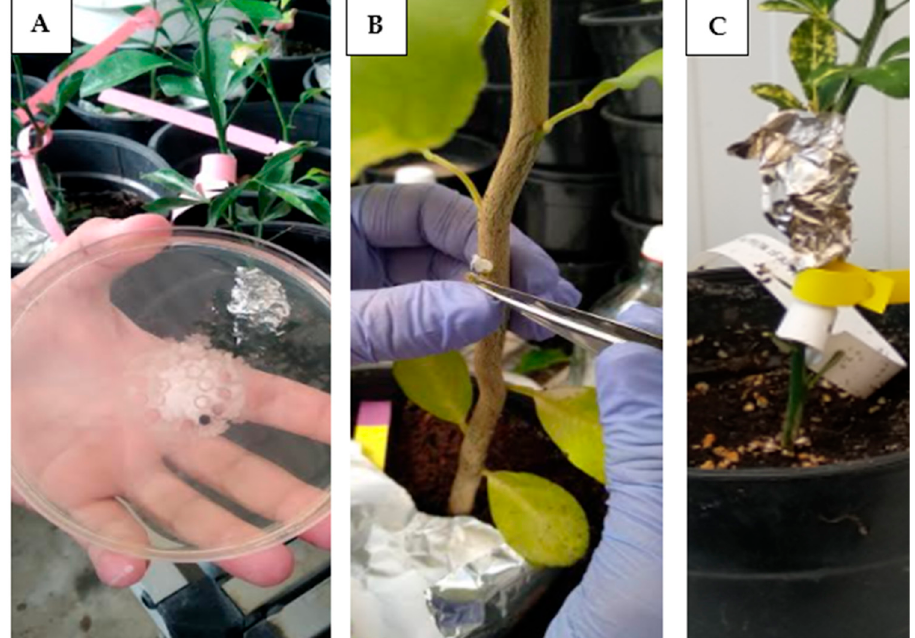
Figure 1. Phytophthora nicotianae inoculation process in stem of citrus plant: 5-mm mycelial disks of P. nicotianae in PDA petri dishes ( A ); P. nicotianae PDA mycelial disks on the citrus plant stem covering with a piece of citrus rootstock bark using laboratory tweezers ( B ); inoculated citrus plant covered with wet cotton (distilled water) and aluminum paper ( C